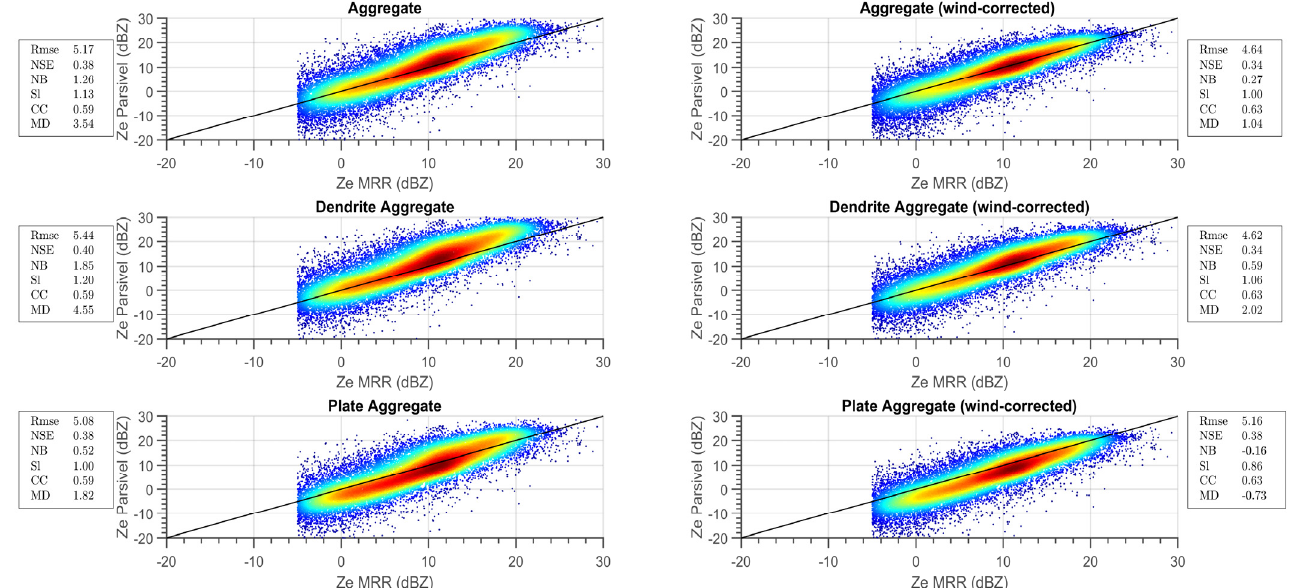
Figure 4. Density scatter plots for 1-min MRR and disdrometer data in terms of equivalent radar reflectivity for aggregate-like categories. Disdrometer observations are not corrected (left column) and corrected (right column) for wind influence. Points are colored based on data density ranging from dark red (high density) to dark blue (low density), whereas the black line represents the bisecting line. Merit factors of the comparisons are also reported next to each plot.